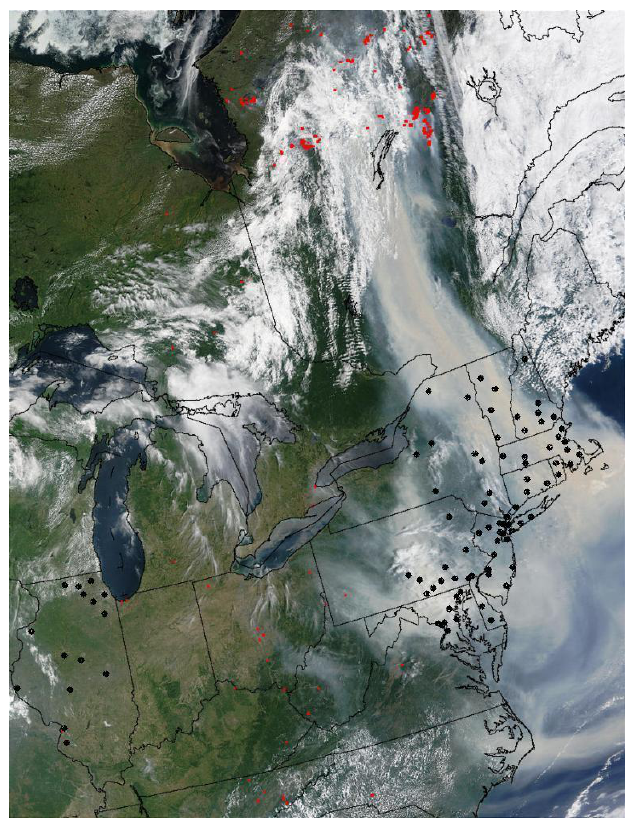
Figure 1. MODIS satellite image taken on 7 July 2002, 10:35 EDT. The red dots mark areas of high forest fire activity. The black dots represent the centroids of counties used in our